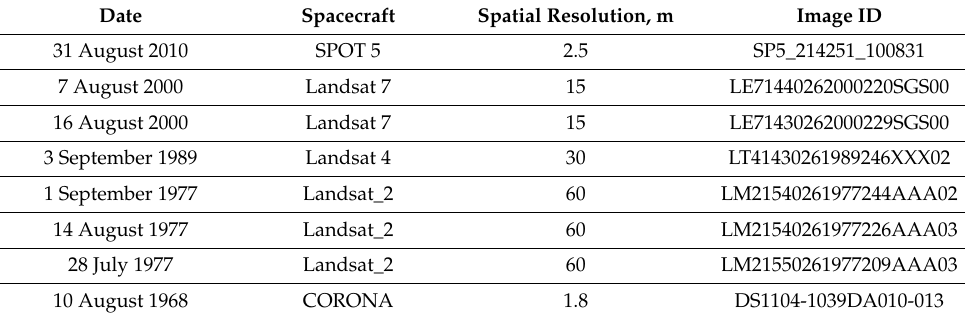
Table 1. Satellite imagery used in the study of Tavan Bogd glaciers in the